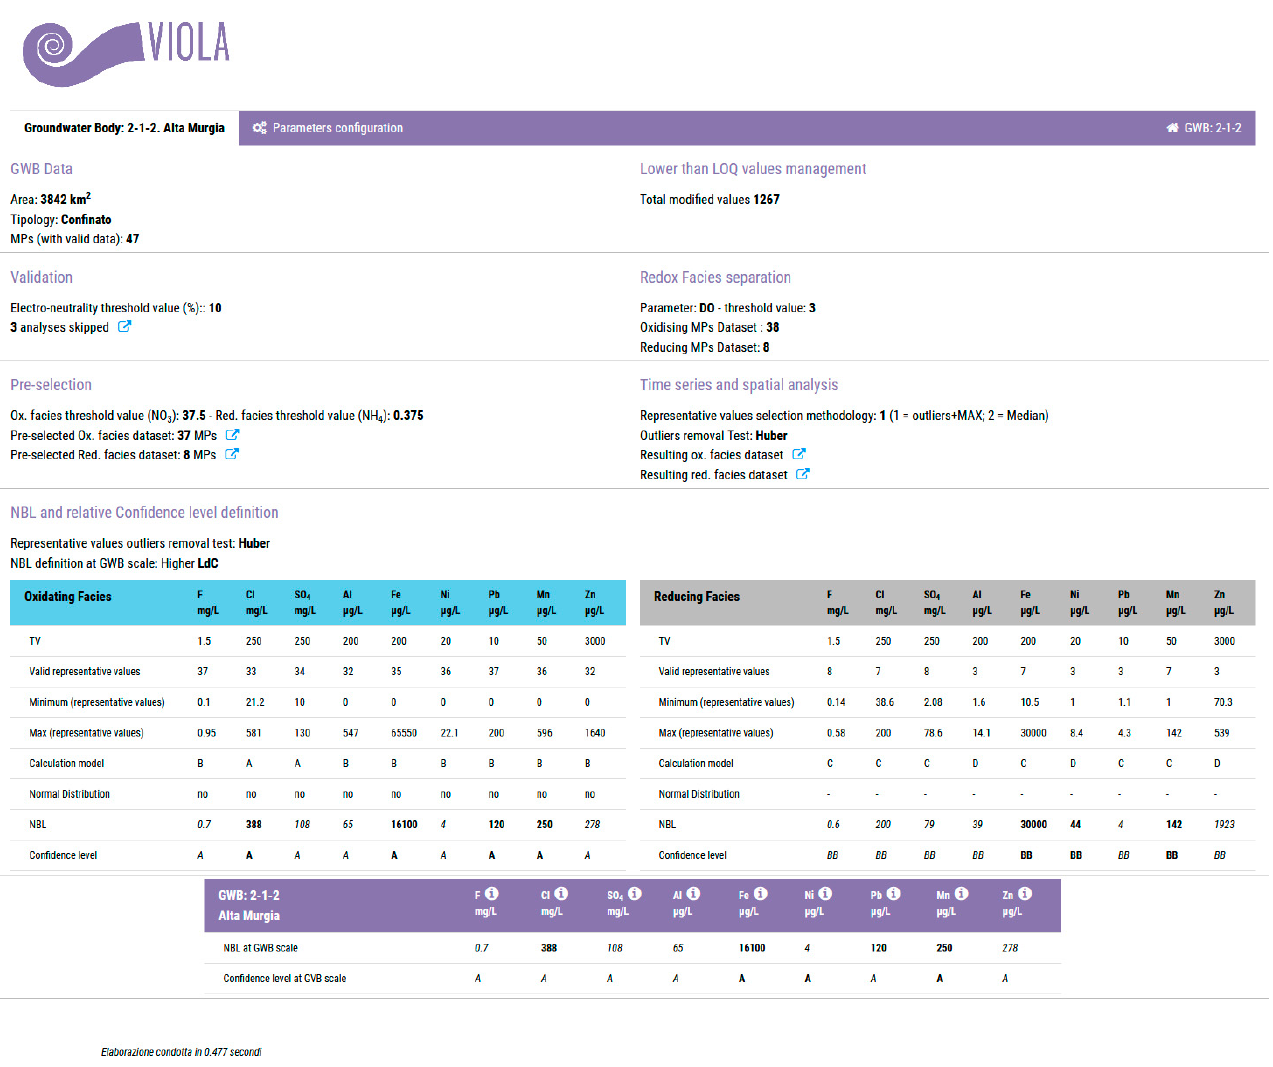
Figure 2. Results of the NBLs assessment. The GWD characteristics, the computational settings and the link to the intermediate and processed datasets are listed in the upper part, while the values of the NBLs for the selected parameters and the relative confidence levels appear in the lower part.